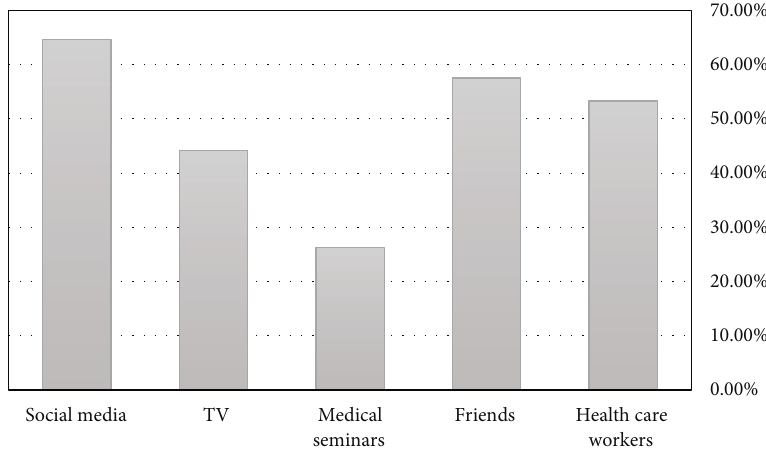
Figure 1: The source information on osteoporosis among the participating